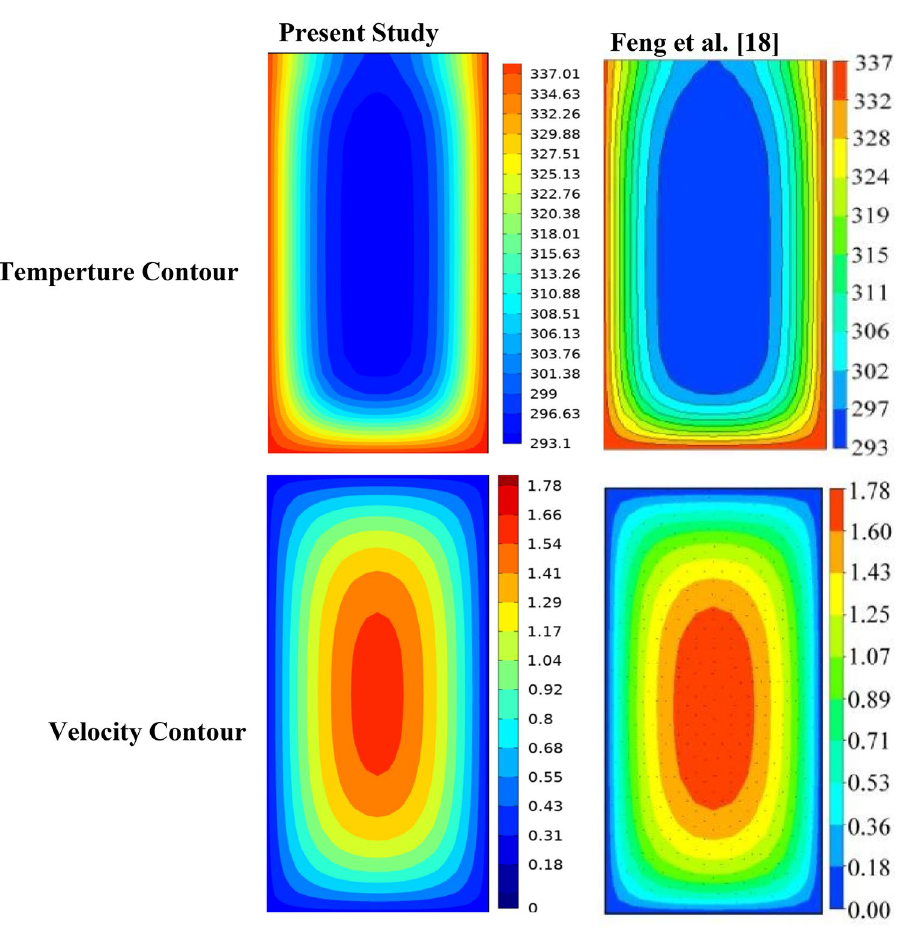
Figure 3. Temperature and velocity contours comparsion between present work and Feng et al. 14 on a cross section (x/L = 0.625) in microchannel at Re = 663 and qw = 400 kW/m 2